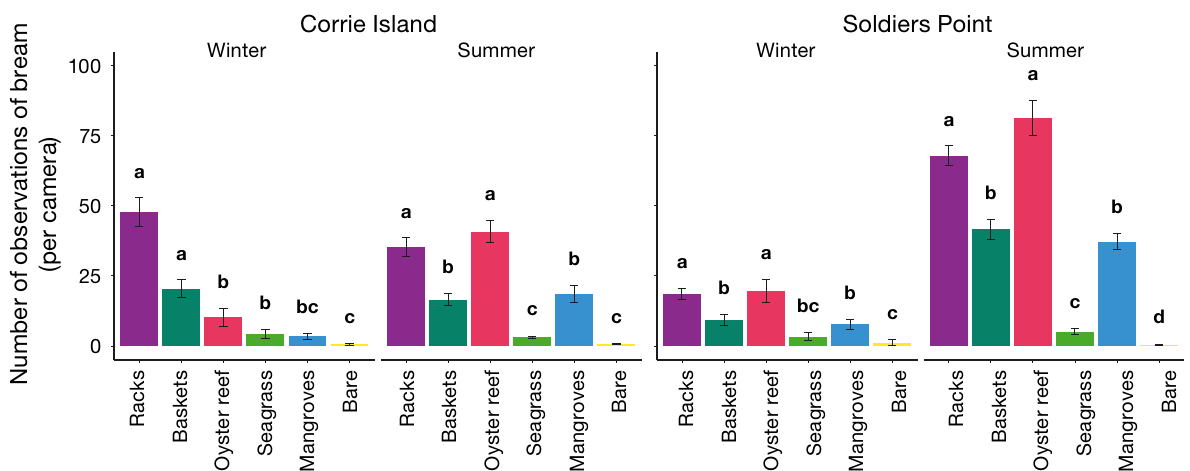
Fig. 6. Mean (±SE) observations of bream as documented by 75 min remote underwater video deployments. Data are aver- aged across the 2 study years, as these did not significantly differ, with 4 cameras deployed on 3 replicate days of each season and year, to give n = 24. Letters above columns denote treatments that were significantly different (at α = 0.05) within each site and season by estimated marginal